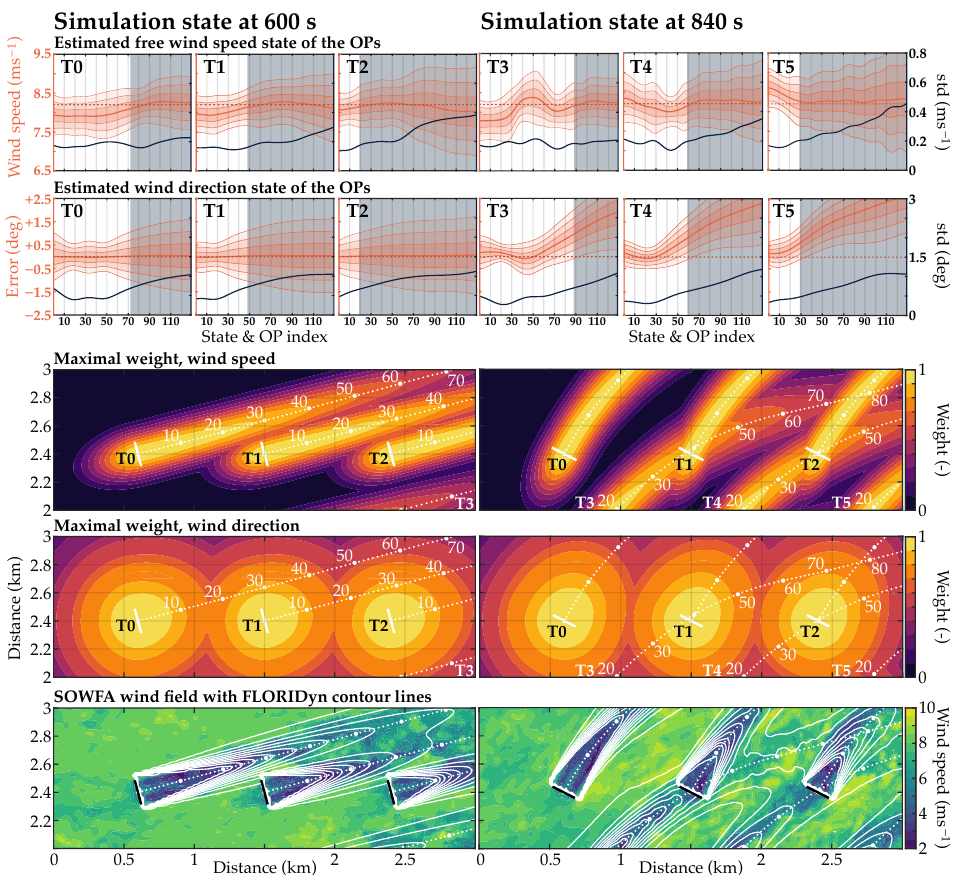
Figure 11. This figure compares the simulation state at the start and during the wind direction change. The top two figure rows visualize the states of all OPs connected to Turbine 0 to 2, at t 1 = 600 s and of all OPs connected to Turbine 3 to 5, at t 2 = 840 s. The figures show the state value of the OPs with 1, 2 and 3 standard deviations (std) as orange plot and y-axis, and the std alone as black plot and y-axis. A gray area marks the OPs which have left the wind farm boundaries. The x-axis denotes the state index, e.g., 10 relates to the 10th OP. The dotted lines mark a reference value: for the wind direction, this is the true value; for the wind speed, this is the average precursor speed. Below the OP states are three rows of flow field plots. They show a third of the wind farm to allow for a more detailed look. The upper two show the weights used for the weighted average calculation; see Equation (6). These figures also show the state indexes in the wakes of the referenced turbines. The lower row shows the SOWFA flow field overlapped with the contour lines of the FLORIDyn simulation. The dataset [35] provides animations of the state figures for all cases and animations of the flow